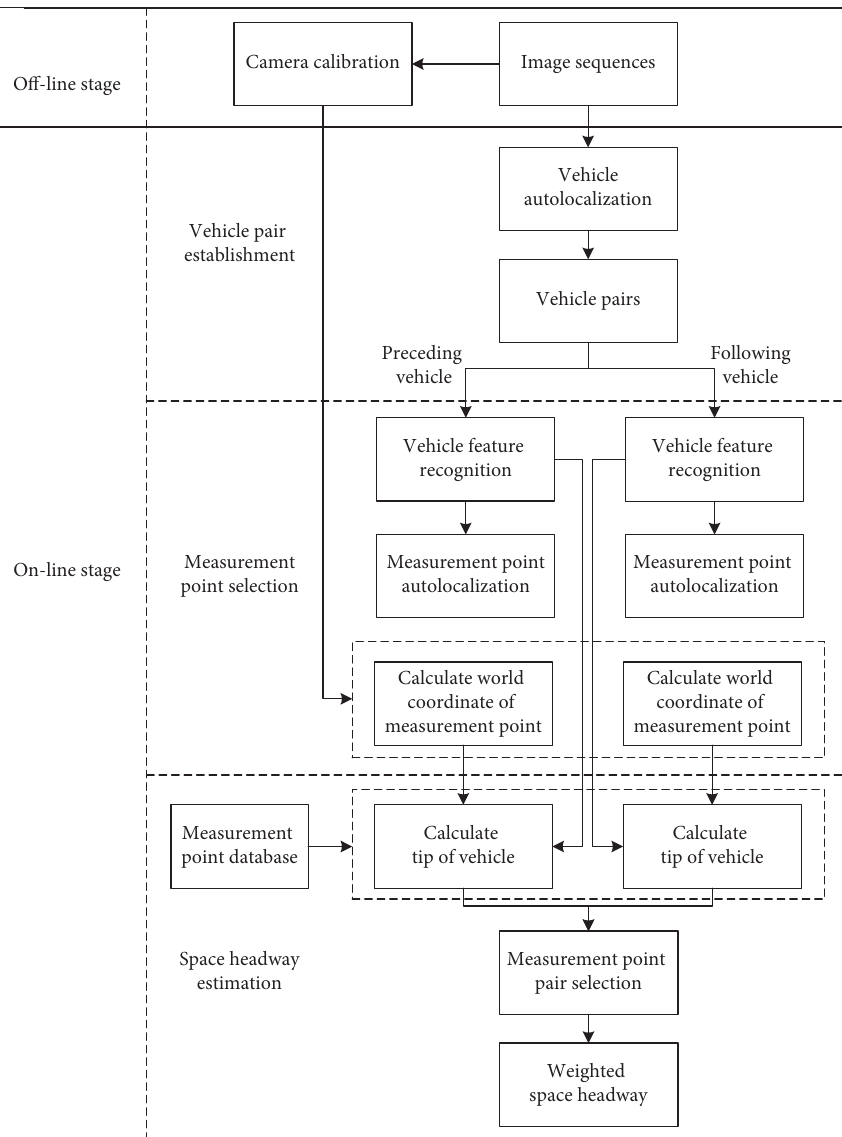
Figure 1: Proposed